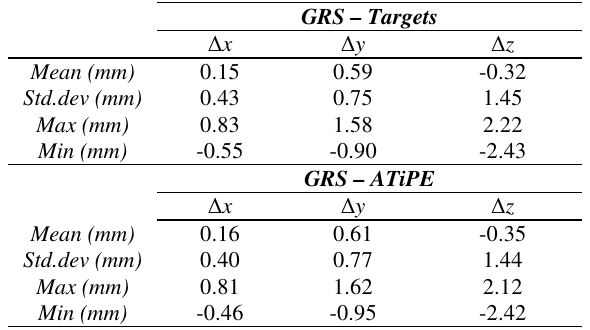
Table 3. Comparison between ChkP coordinates measured with a theodolite (GRS) and photogrammetric measurements with and without targets (ATiPE). The behaviour and the residuals are similar for both photogrammetric approaches.